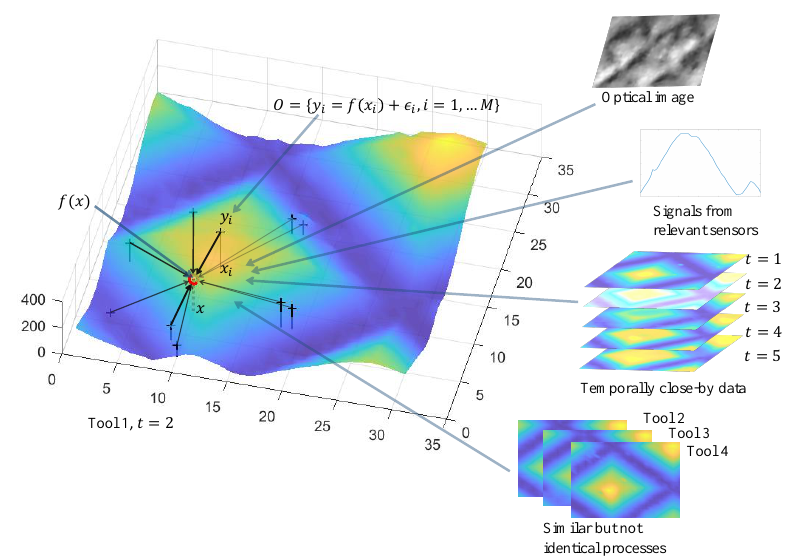
Figure 4. An illustration of data fusion methods for continuous